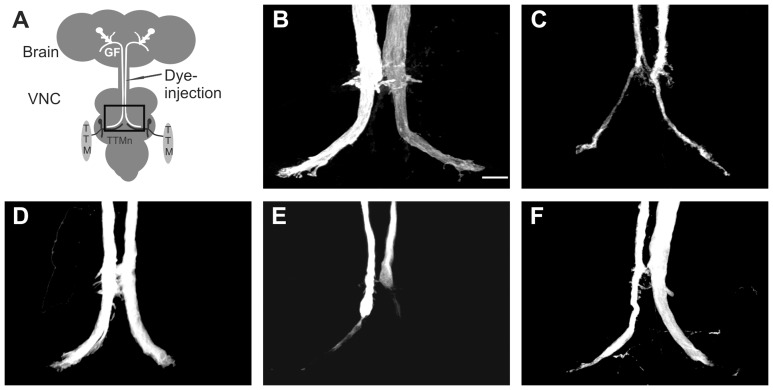
Anatomical characterization of GF-TTMn synaptic defects of L1CAM constructs in nrg14;P[nrg180ΔFIGQY] background.(A) Schematic of the GF to TTM circuit in Drosophila. Rhodamine-dextran was injected into the GF in the cervical connective to visualize the synaptic terminal. Rectangle highlights the region in the thoracic ganglion depicted in B-F. (B) Wild-type control flies exhibited a large synaptic terminal in the second neuromere of the VNC. Scale bar represents 10 µm. (C) The GF terminals of nrg14;P[nrg180ΔFIGQY] were skinnier (and sometimes also shorter) when compared to wild-type control flies. (D) The size of the synaptic terminal was restored in nrg14;P[nrg180ΔFIGQY] animals that expressed UAS-L1 driven by OK307. (E) The synaptic terminal in nrg14/>;P[nrg180ΔFIGQY]/OK307,UAS-L1-Y1070C animals was skinny or absent. (F) The morphology of the GF synaptic terminals of nrg14;P[nrg180ΔFIGQY] animals was improved by the expression of UAS-L1-4A with the OK307 Gal4-driver.